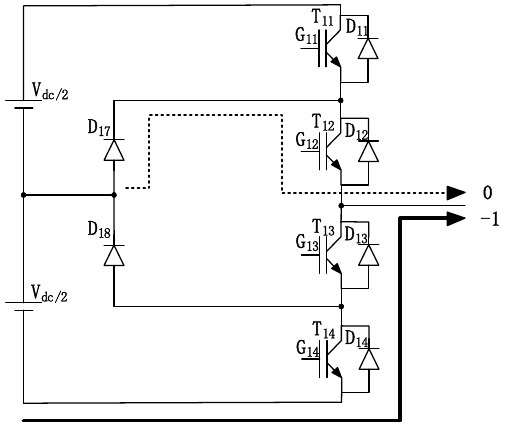
Figure 4. D2 type ( α = − 1, M = 1.15).